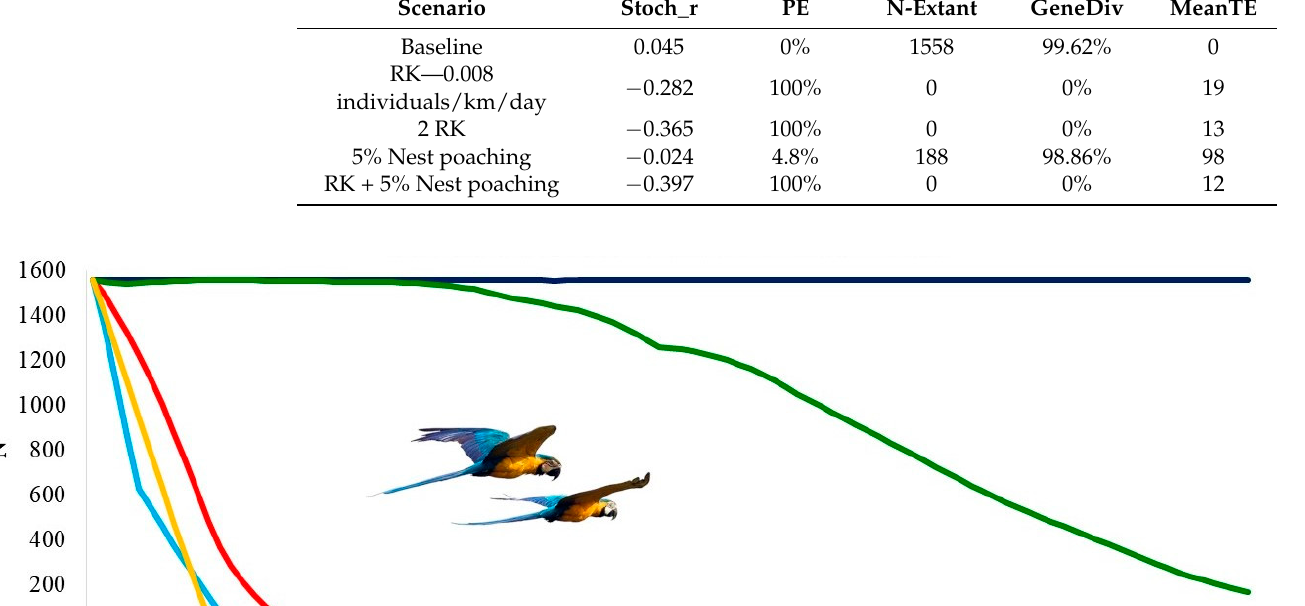
Table 3. Results of mean rate of stochastic population growth (stoch_r), probability of extinction (PE), population size at the end of simulations (N-extant), genetic diversity (GeneDiv), and mean time to extinction (meanTE) for populations of blue-and-yellow macaw ( Ara ararauna ) in Emas National Park, Brazil, suffering from different levels of roadkill (RK) and nest poaching.